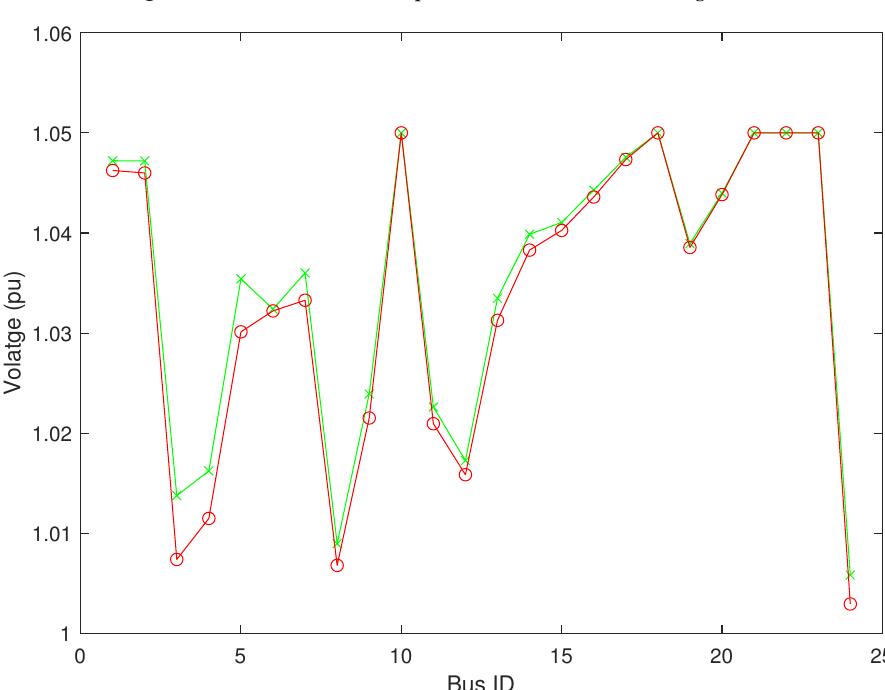
Figure 7. DB attack with line parameter alteration of multiple